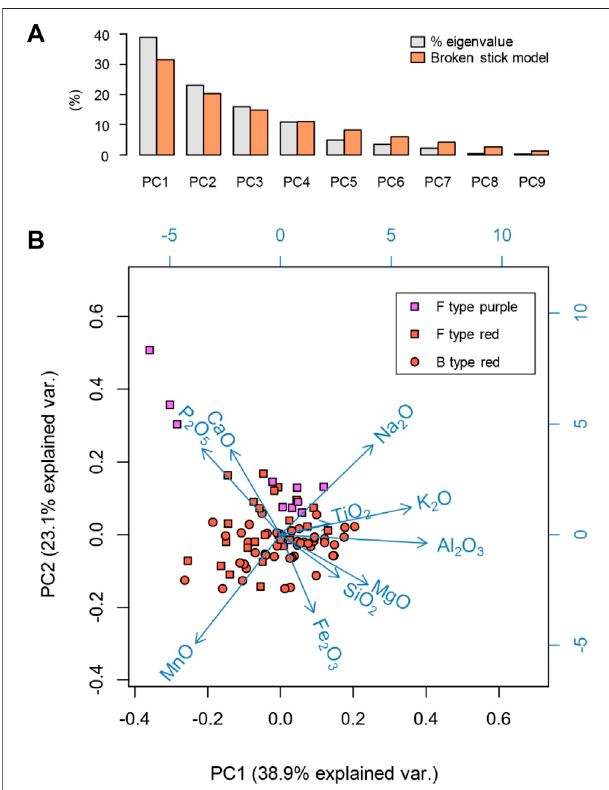
FIGURE8|(A) Scree plotofthePCA resultand theBroken-Stick model (MacArthur, 1957) for the clr-transformed dataset of intercalated mudstones of Section R and Section Q. (B) Biplot of principal component scores and loadings for the PC1 and PC2.